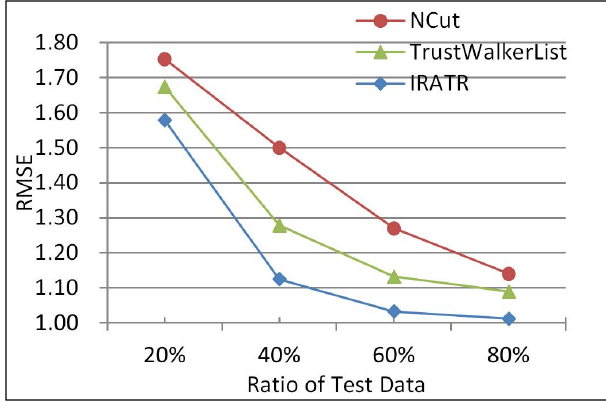
Figure 4. Comparison at different sparsity.